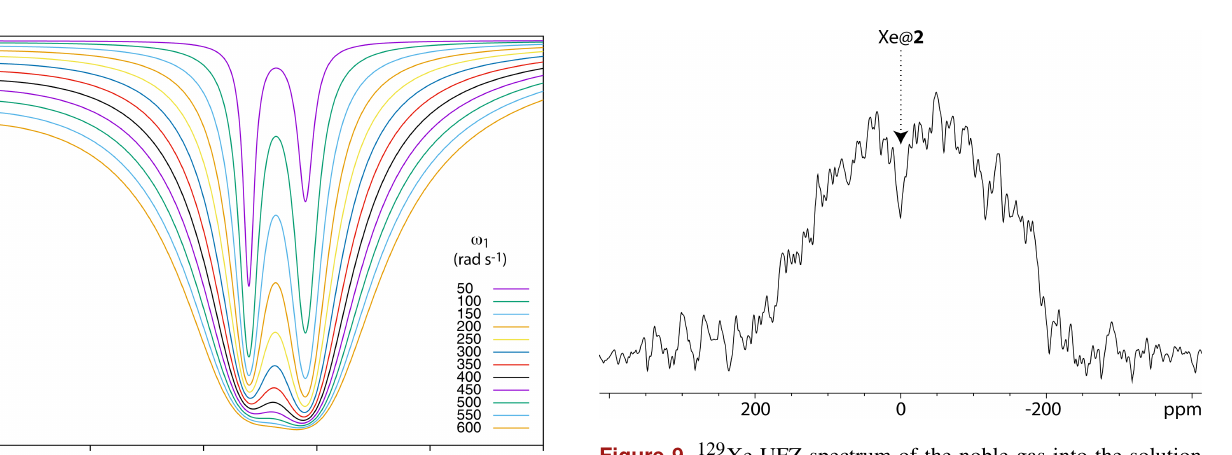
Figure 9. 129 Xe UFZ spectrum of the noble gas into the solution containing cryptophane 2 at 19.2µM. Magnetic field: 1T; temper- ature 295K, same pulse sequence as for Fig. 4 (one scan). ω B was placed at the Xe@2 frequency. Profile obtained after 3s satura- tion at a field strength B 1 = ω 1 /γ = 1 . 24µT. G sat = 21mTm − 1 ; G acq = 84mTm − 1